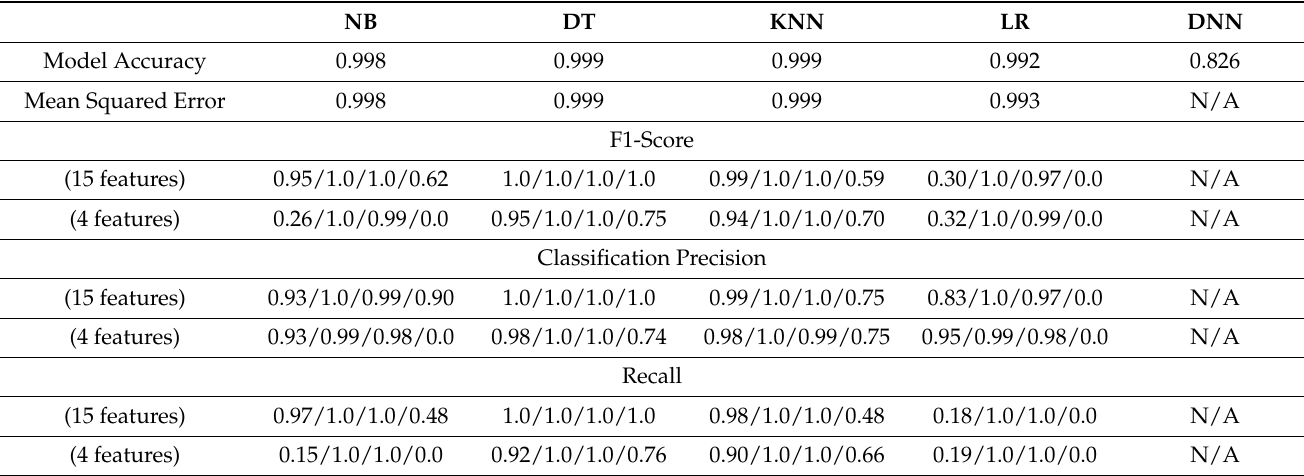
Table 2. ML Metrics of ML